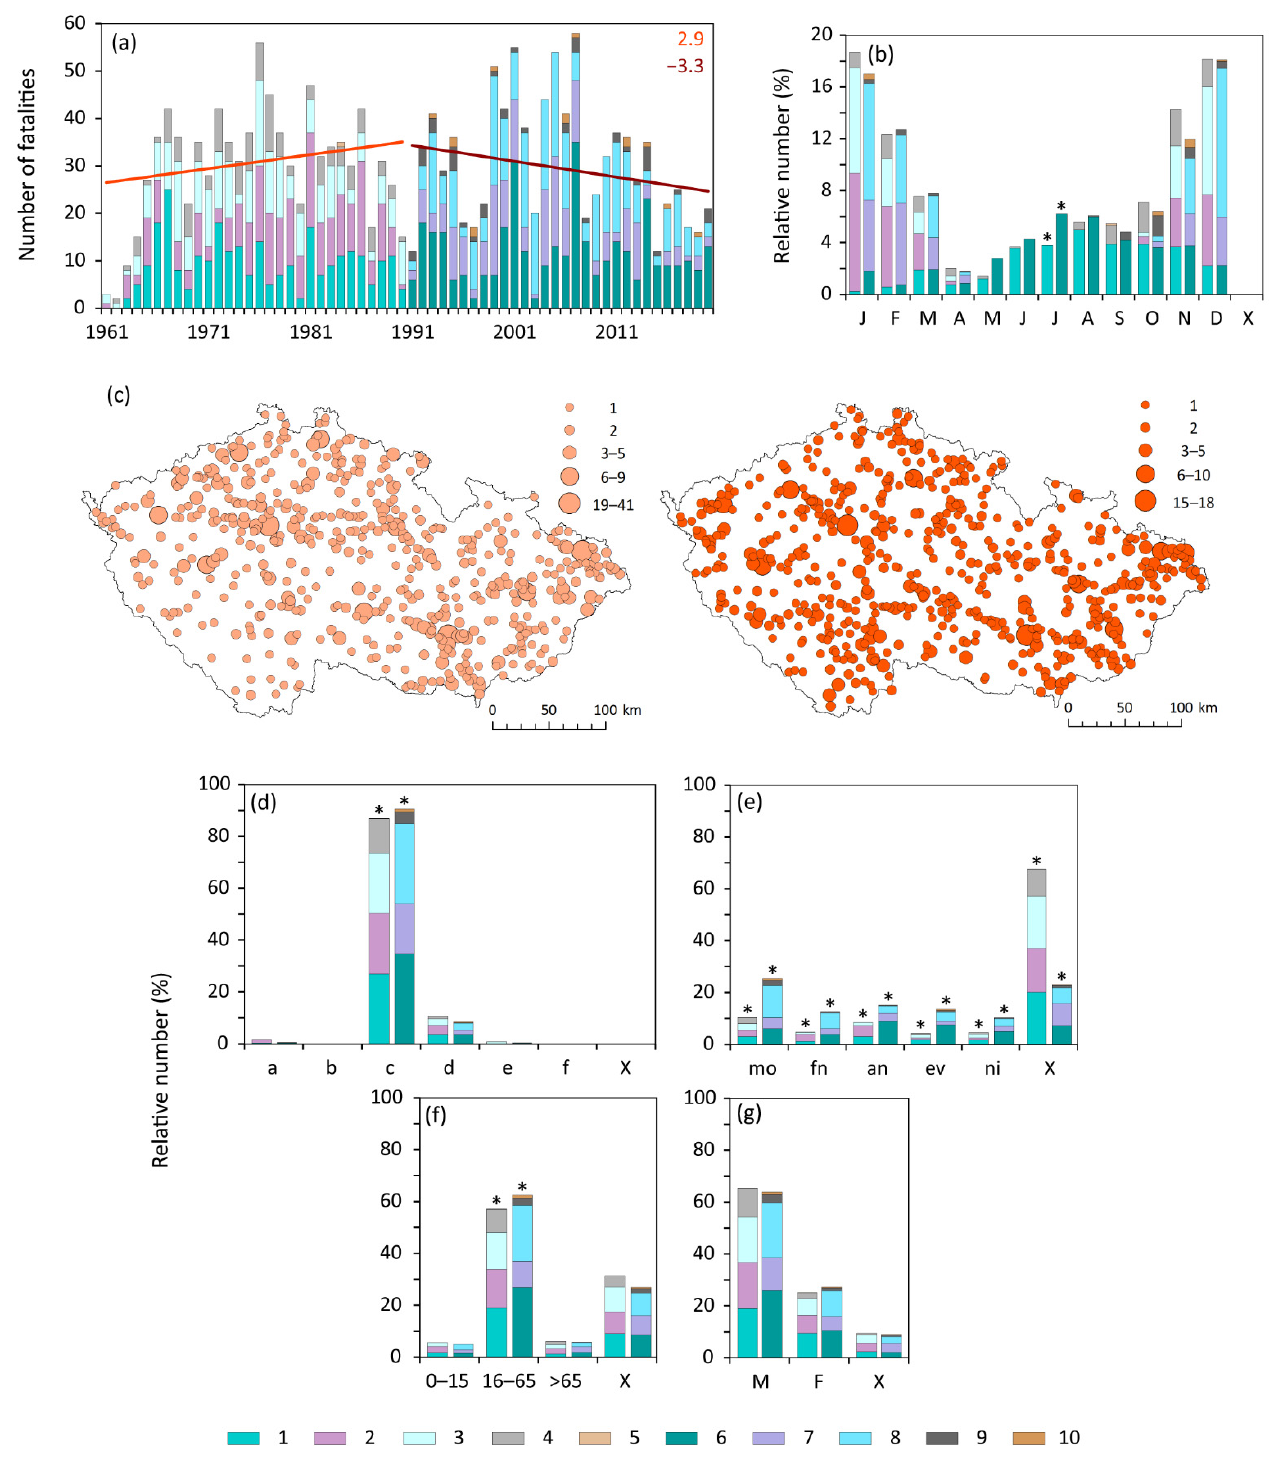
Figure 8. Characteristics of vehicle accident fatalities associated with inclement weather (1, 6—rain and wet road, 2, 7—snow (snowfall), 3, 8—glaze ice, 4, 9—fog, 5, 10—other inclement weather) in the Czech Republic during the 1961–1990 and 1991–2020 periods. ( a ) Fluctuations with linear trends (top right in fatalities/10 years for both 30-year periods); ( b ) annual variation; ( c ) spatial distribution (27 fatalities in each of 30-year periods lack exact location); ( d ) place of death; ( e ) time of day; ( f ) age; ( g ) gender. For an explanation of symbols and abbreviations see Figure 2.